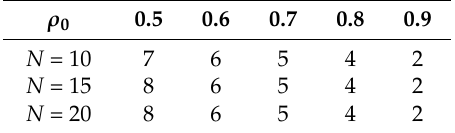
Table 6. Number of representative nodes with the distortion D = 0.1.